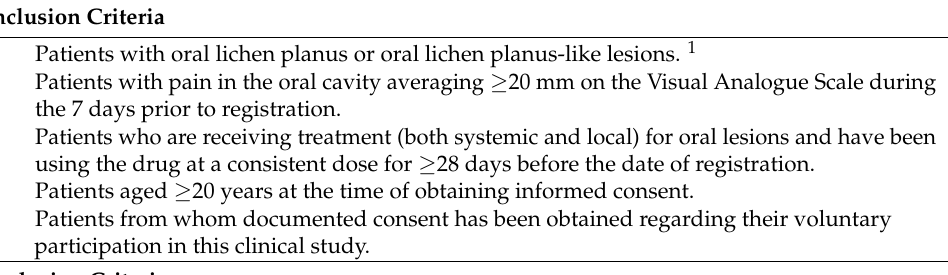
Table 1. Inclusion and exclusion criteria for the crossover